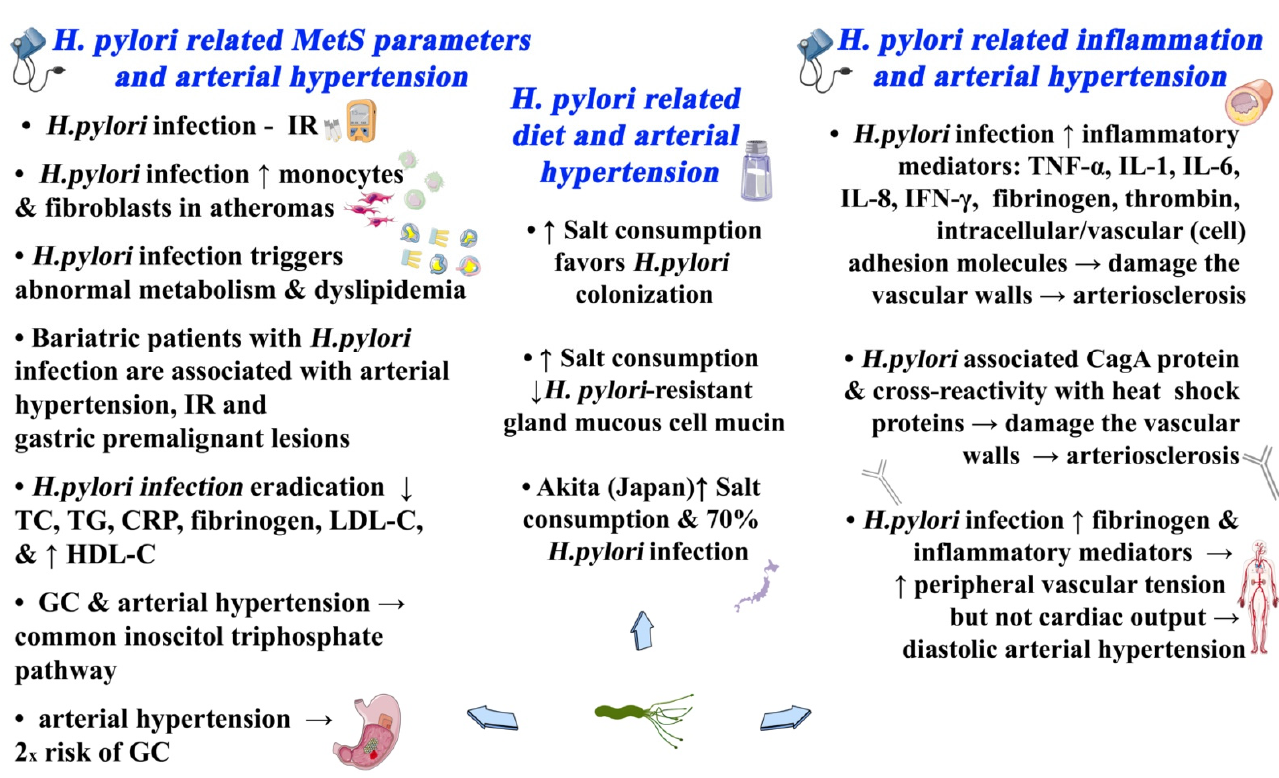
Figure 1. Proposed pathogenetic mechanisms, owing to H. pylori infection-related MetS, that may contribute to arterial hypertension. CagA, cytotoxin-associated gene A; CRP, C-reactive protein; HDL-C, high-density lipoprotein cholesterol; H. pylori, Helicobacter pylori ; IL, interleukin; IR, insulin resistance; LDL-C, low-density lipoprotein-cholesterol; MetS, metabolic syndrome; TC, total cholesterol; TG, triglycerides; TNF, tumor necrosis factor.